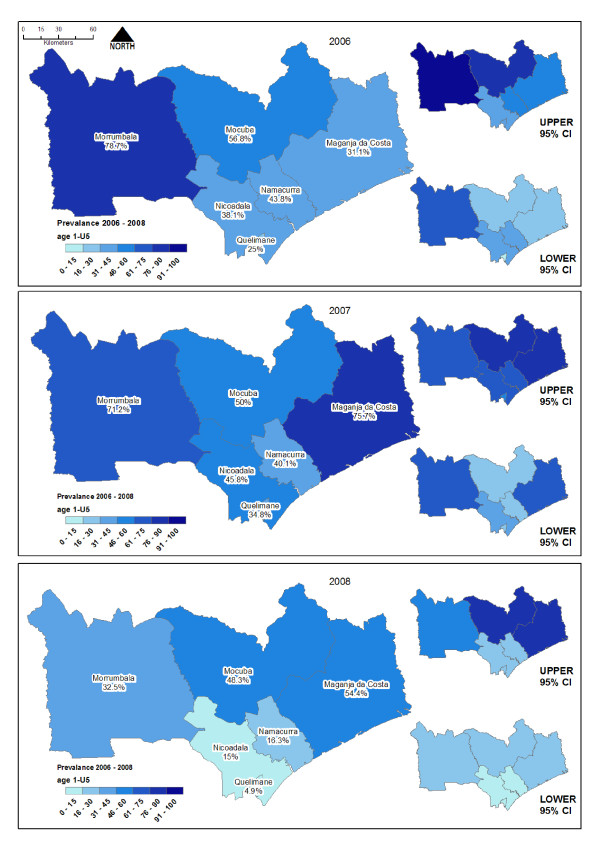
Temporal change in prevalence of P. falciparum in children 1 to 15 years of age between 2006 and 2009.